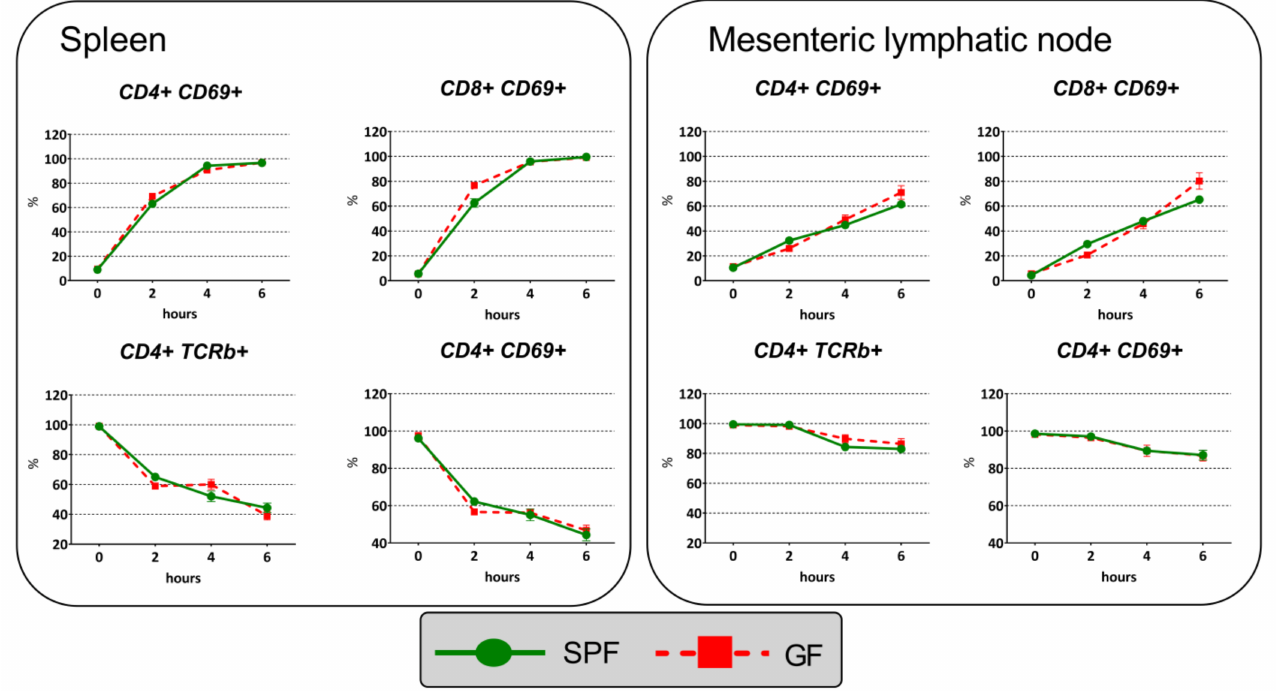
Figure 7. Changes in the expression of the T-cell activation markers CD69 and TCR β in CD4 + and CD8 + subpopulations of CD3 + T cells isolated from spleen and mesenteric lymphatic nodes after their activation via anti-CD3 crosslinking of the T-cell receptor. The data are shown as mean percentages ± SEM. Two-way ANOVA identified the effect of time ( p < 10 − 6 ), but not the effect of microbiota ( p > 0.05) or interaction time*microbiota ( p >